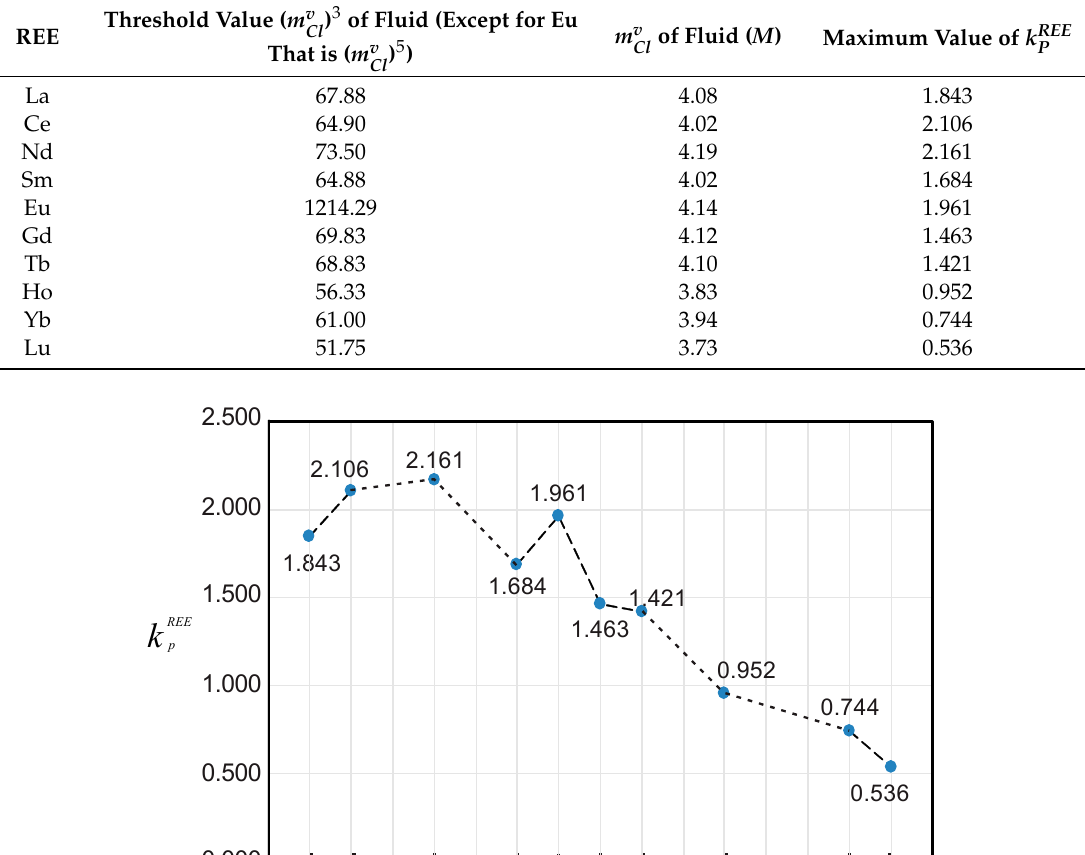
) 3 of magmatic fluids (note: for Eu, it should be Cl P